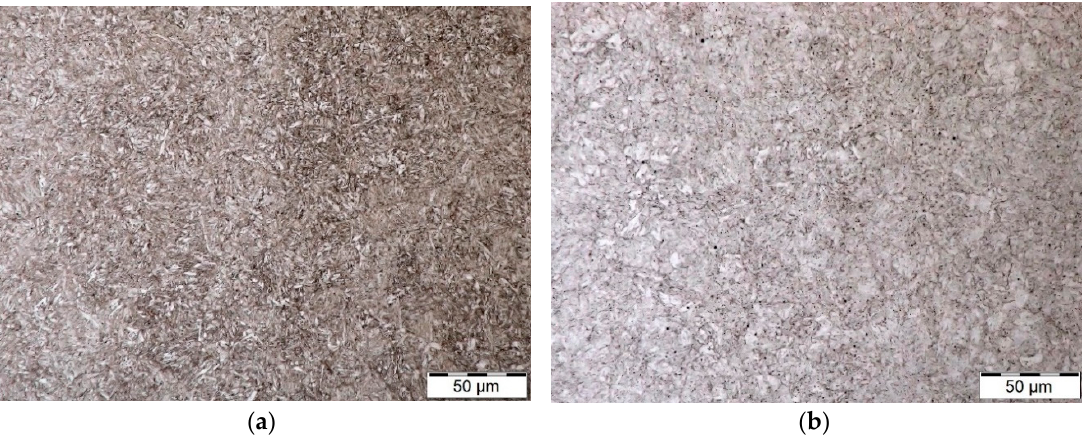
Figure 1. Microstructure of hardened and tempered material magnified 1000×; ( a ) steel equivalent 42CrMo4 (i.e., CSN 41 5142) on left; ( b ) 17Ni4CrMo (i.e., CSN 41 6720) on right.